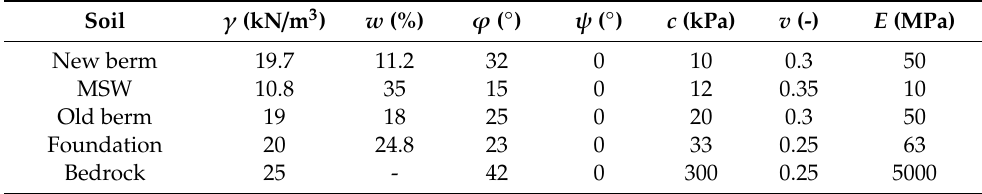
Table 1. Soil propriety of the Xingfeng municipal solid waste (MSW) landfill site. γ : unit weight; w : moisture content; c : cohesion; ϕ : friction angle; ψ : dilatancy angle; E : Young’s modulus;